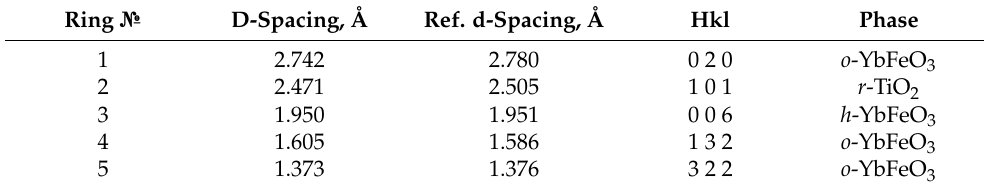
Table 1. Results of phase analysis by SAED.